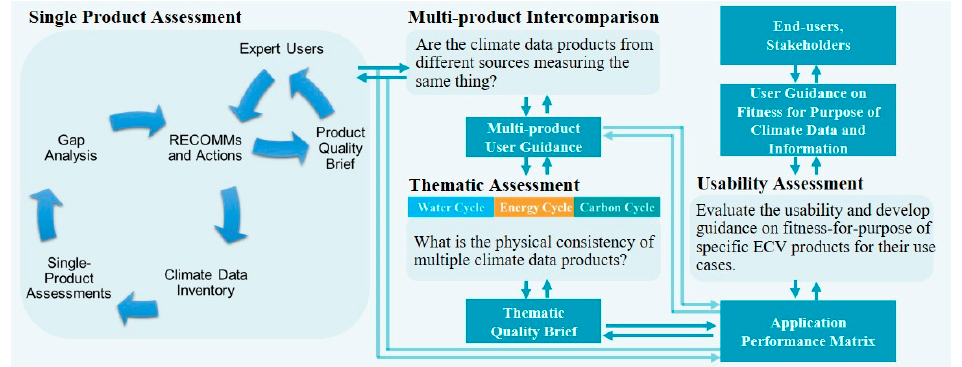
Figure 1. Overarching structure for the assessment of quality and usability of Essential Climate Variable (ECV) products (incl. single-products, multi-products and thematic products, as well as user-provider feedback mechanisms). (RECOMMs – Recommendations).